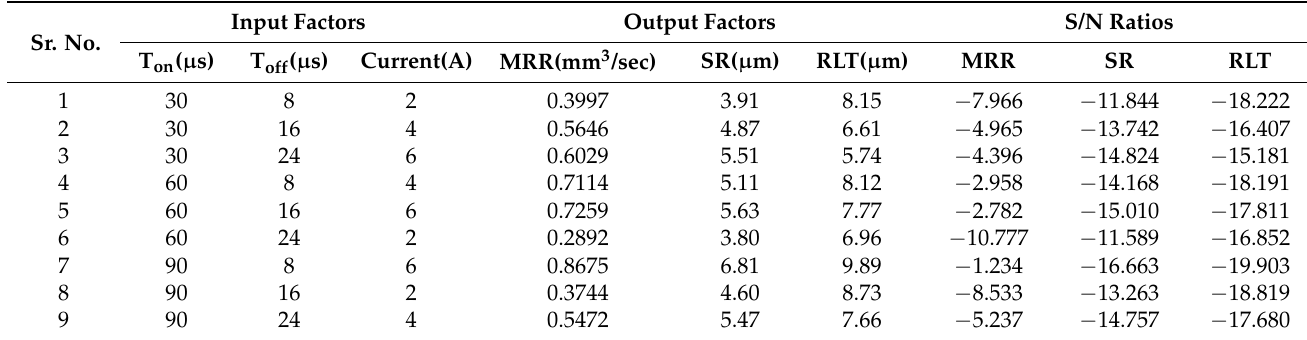
Table 2. Obtained results of near-dry WEDM trials for performance